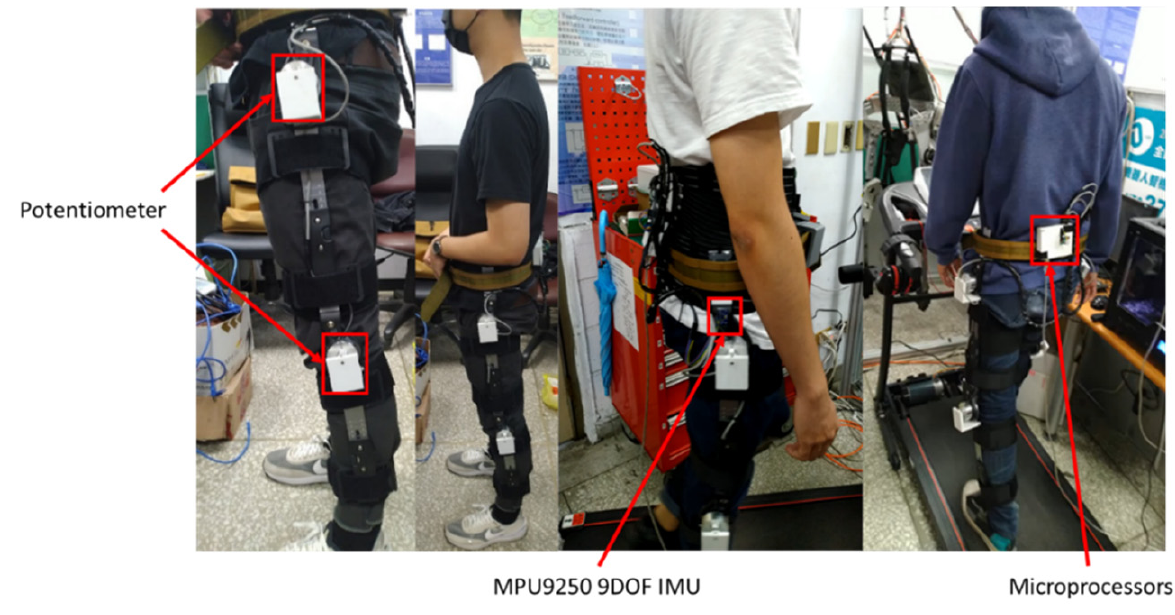
Figure 8. Wearing an unpowered exoskeleton.